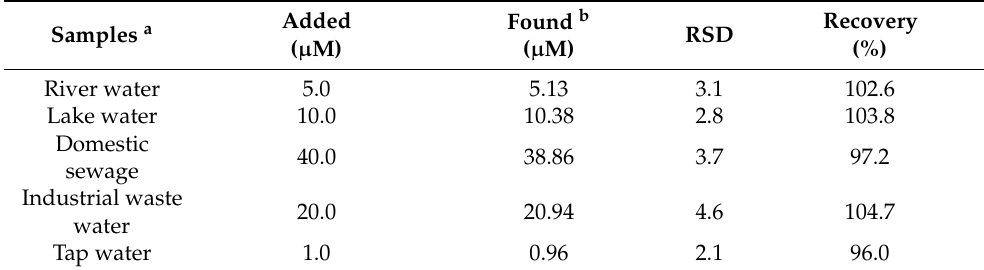
Table 2. Determination of 4-NP in water